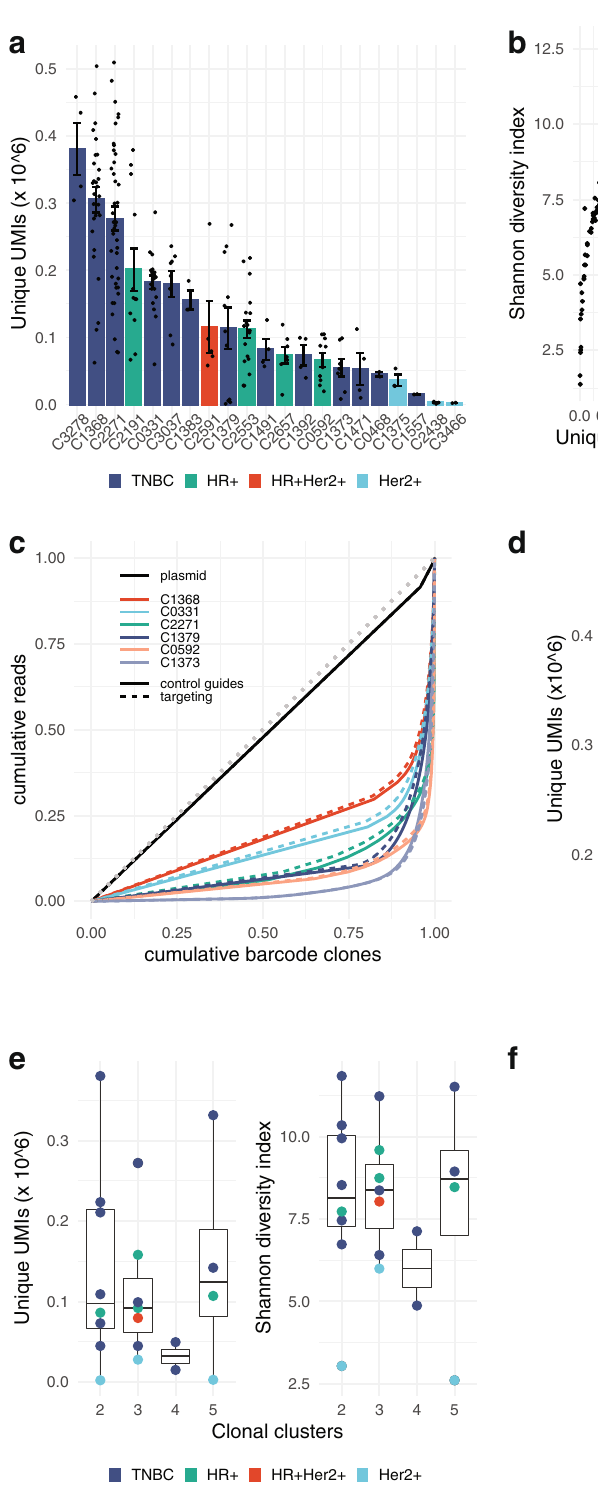
measure of evenness of clone size distribution and total clone number; and the area under the Lorenz curve plot of cumulative reads against cumulative clones, a function of clone size distribution alone (Fig. 2b, c, Supplementary Methods 1.2). We found clone number to be positively correlated with SDI and with homogeneity in clone size (Fig. 2b), with tumour composition ranging from extremes of large numbers of more evenly-sized clones (high entropy) to small numbers of more